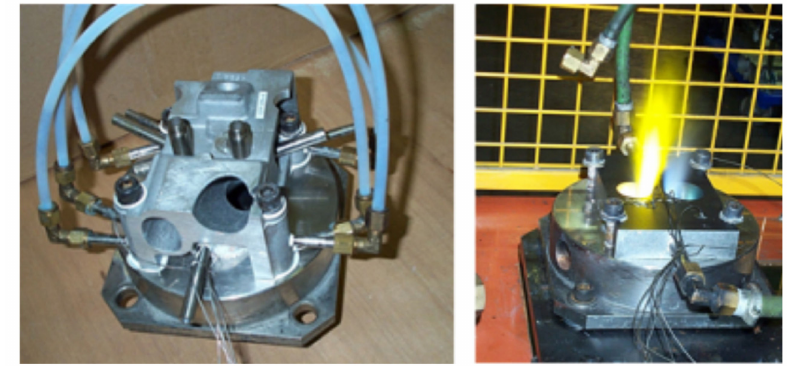
Figure 14. Single-cylinder specimens and experimental set-up with blowtorch